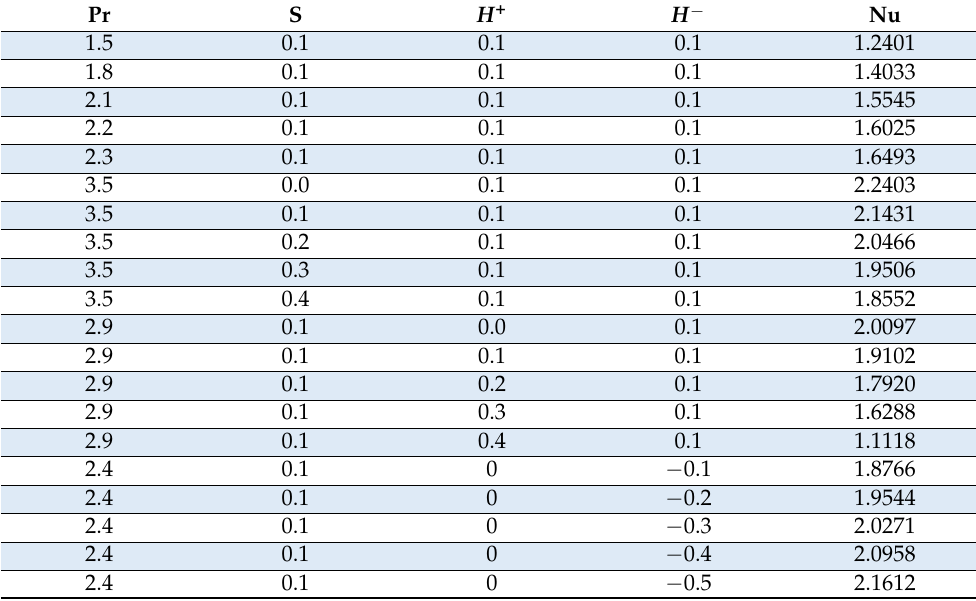
Table 2. Nusselt number variations subject to Flow